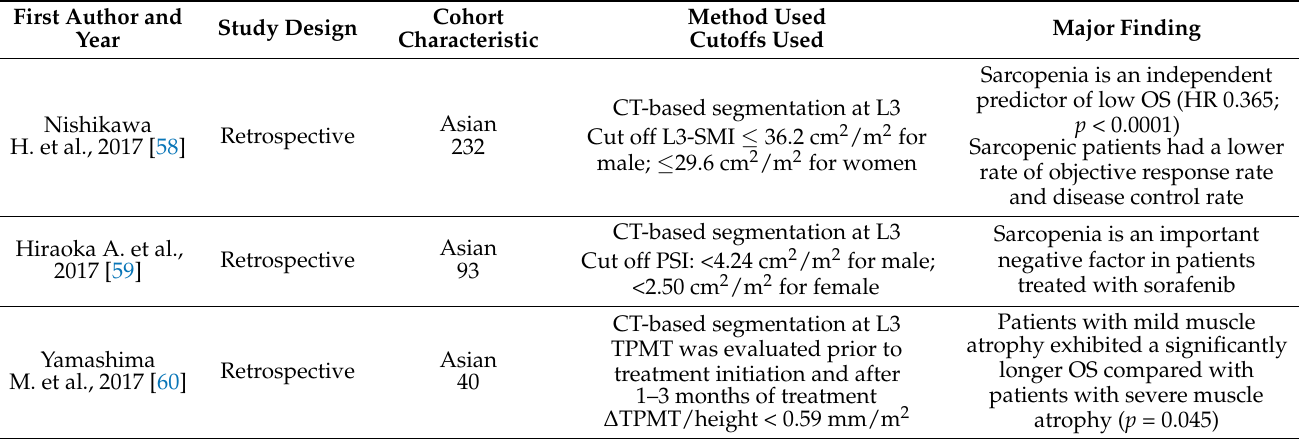
Table 2. Summary of published studies, in the last five years, evaluating the impact of skeletal musculature changes on patient outcomes undergoing systemic therapy (tyrosine kinase inhibitors and